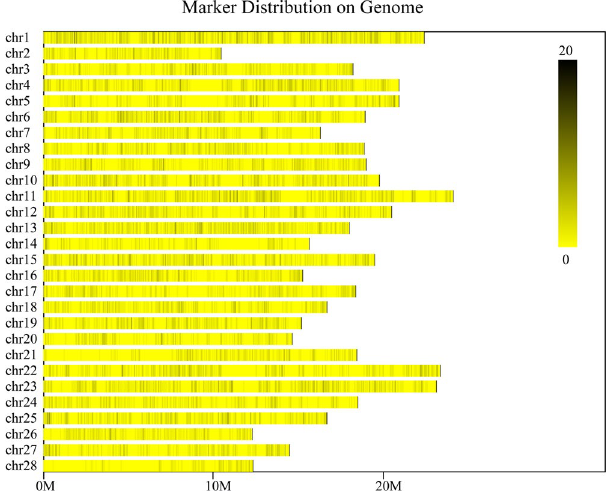
Figure 1. Distribution of polymorphic SLAF-tags on each chromosome in Bombyx mori. The lateral bars represent the chromosomes of silkworm and black vertical lines on them means the SLAF-tags.